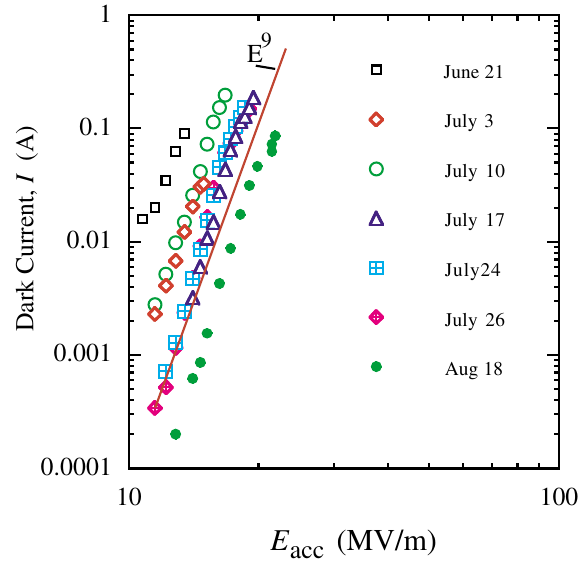
FIG. 5. (Color) High current data during cavity